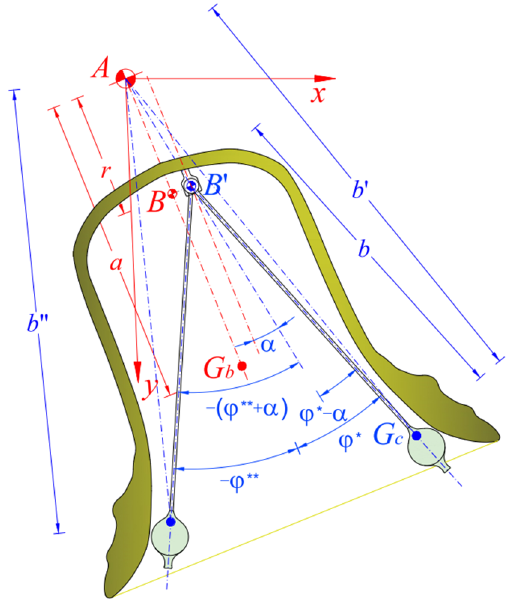
Figure 4. Geometry of the bell in the clapper impact phases.